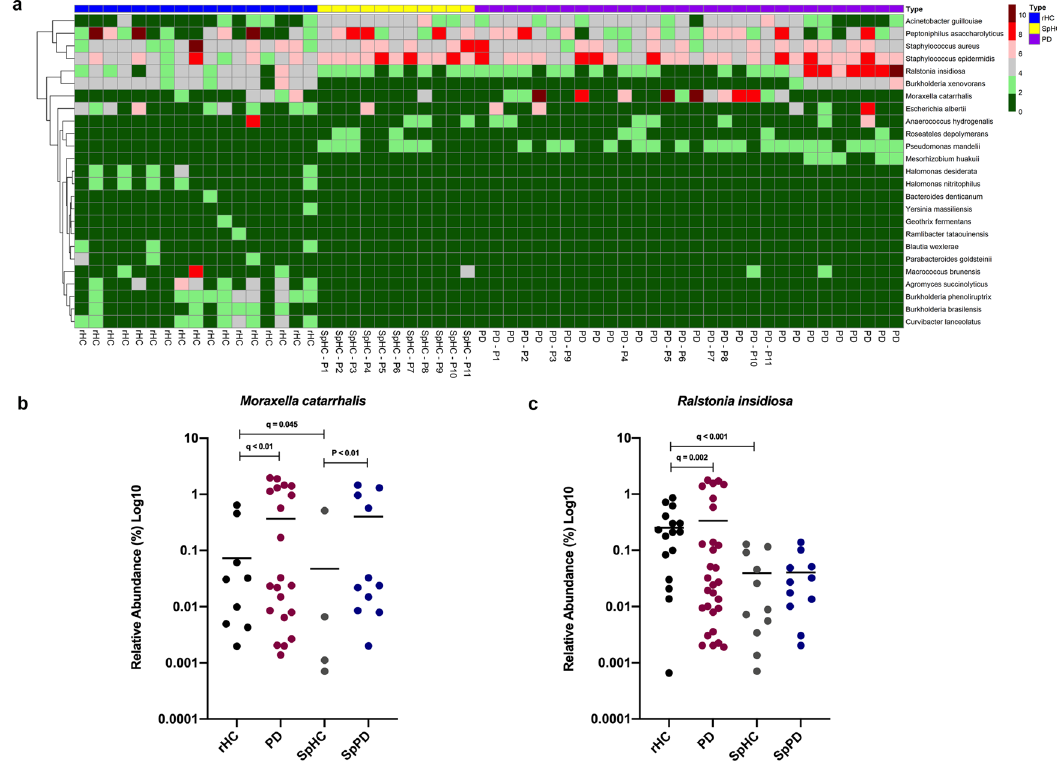
Fig. 2 Differentially abundant deep nasal bacterial taxa between PD and control subjects. a Heatmap showing log10 relative abundance of deep nasal bacterial species in rHC ( n = 17), SpHC ( n = 11), and PD ( n = 30) subjects. Rows include bacterial taxa that are FDR-P signi fi cant with greater than log2 fold change and identi fi ed in the Boruta feature selection algorithm for discernment of PD and rHC microbiomes. The color intensity indicates the direction of effect of relative abundance within samples. Range of colors from pink to red indicate relative abundance values (6 – 10) and a range from green to gray indicate relative abundance values (0 – 4). Each column represents a single sample, and the subject group of each sample is indicated by the top row (rHC (blue), SpHC (yellow), and PD (purple)). Each household pair (SpHC and SpPD) are labeled accordingly with its speci fi c pair number. Relative abundance of b Moraxella catarrhalis and c Ralstonia insidiosa in rHC ( n = 17), PD ( n = 30), SpHC ( n = 11), and SpPD subjects ( n = 11) are shown. Relative abundance values are displayed as Log(x + 1) on a Log10 scale with y - axis starting at 0.0001, due to bimodal distribution. DESeq2 (q-values) or Wilcoxon-signed rank paired test ( p -values) are